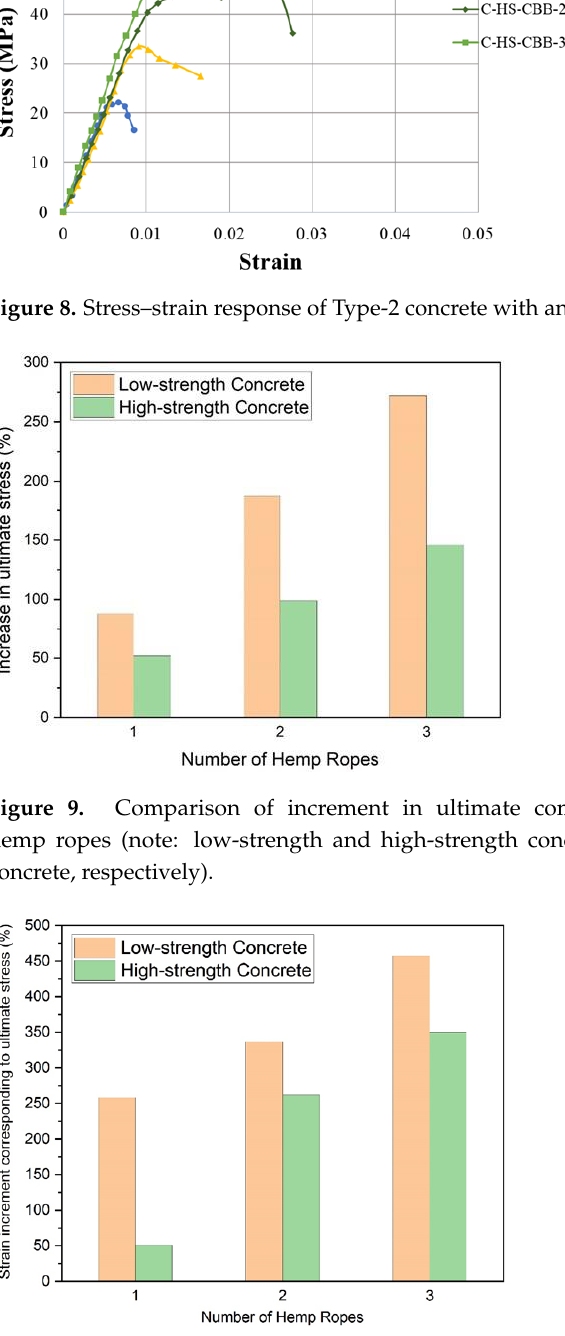
Figure 10. Comparison of increment in strain corresponding to ultimate compressive strength due to number of hemp ropes (note: low-strength and high-strength concrete correspond to Type-1 and Type-2 concrete, respectively).